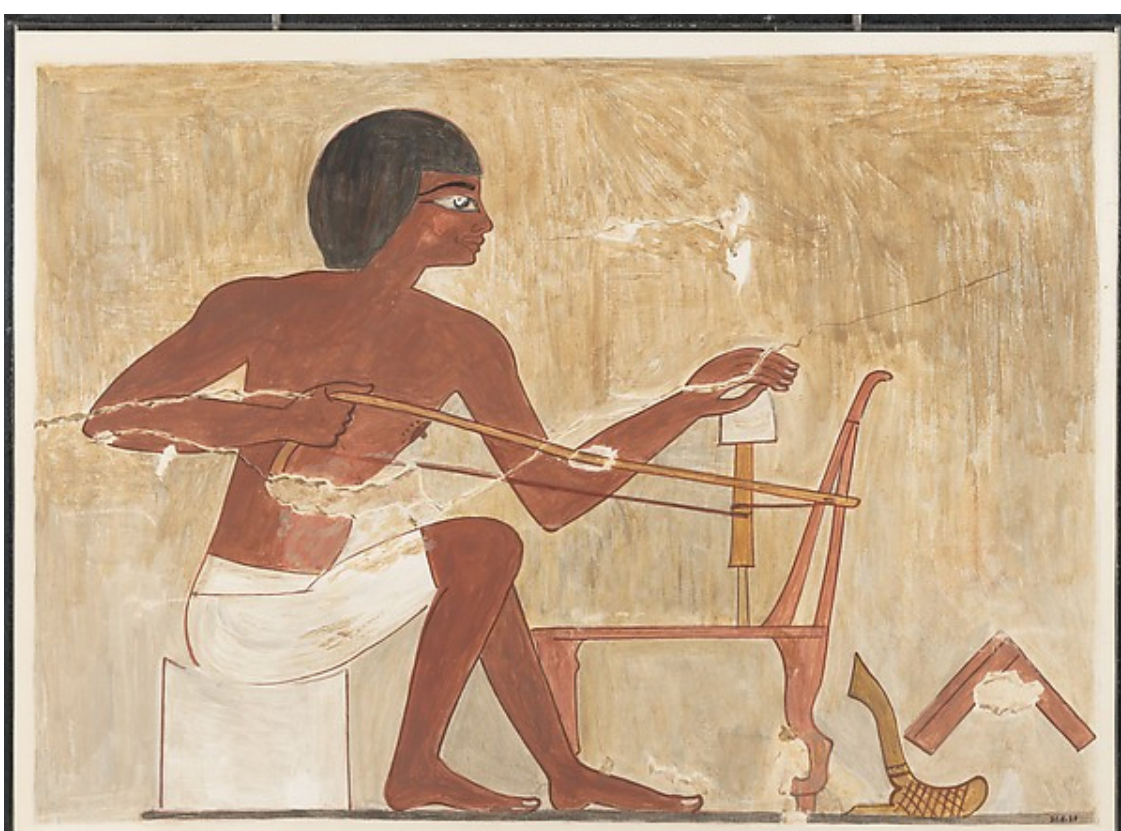
Figure 2. A wall relief from the Tomb of Rekhmire (Theban Tomb 100) showing the drilling operation (Davies 1935: pl. 52). Note the drill socket grasped by the workman at the top of the Journal of Lithic Studies (2016) vol. 3, nr. 3, p. 261-277